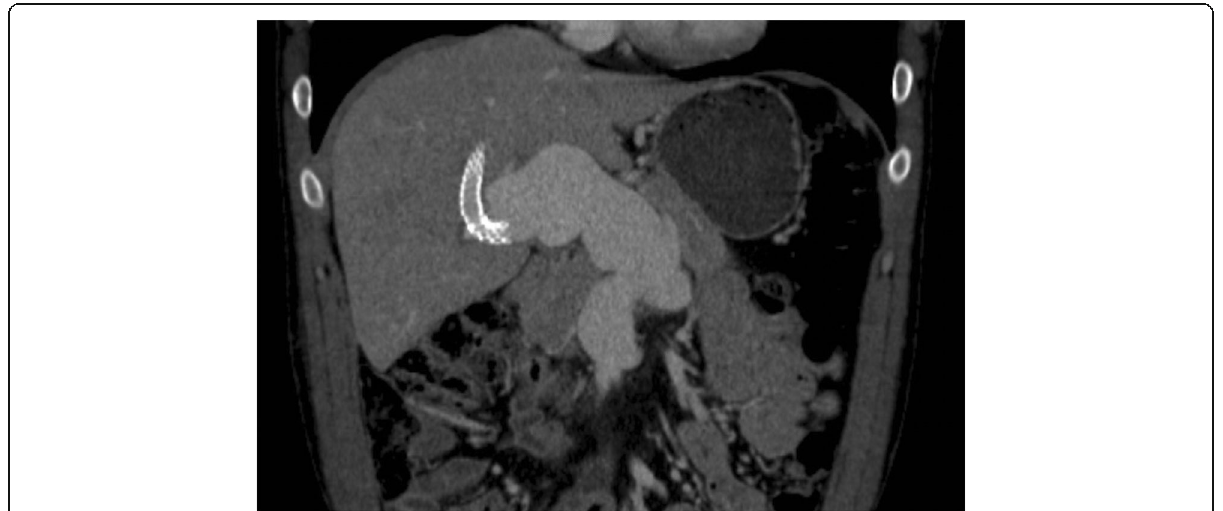
Fig. 4 Coronal contrast-enhanced CT showing the widely patent portomesenteric aneurysm 1-month post-intervention. The right hepatic vein-to- right posterior portal vein TIPS is also